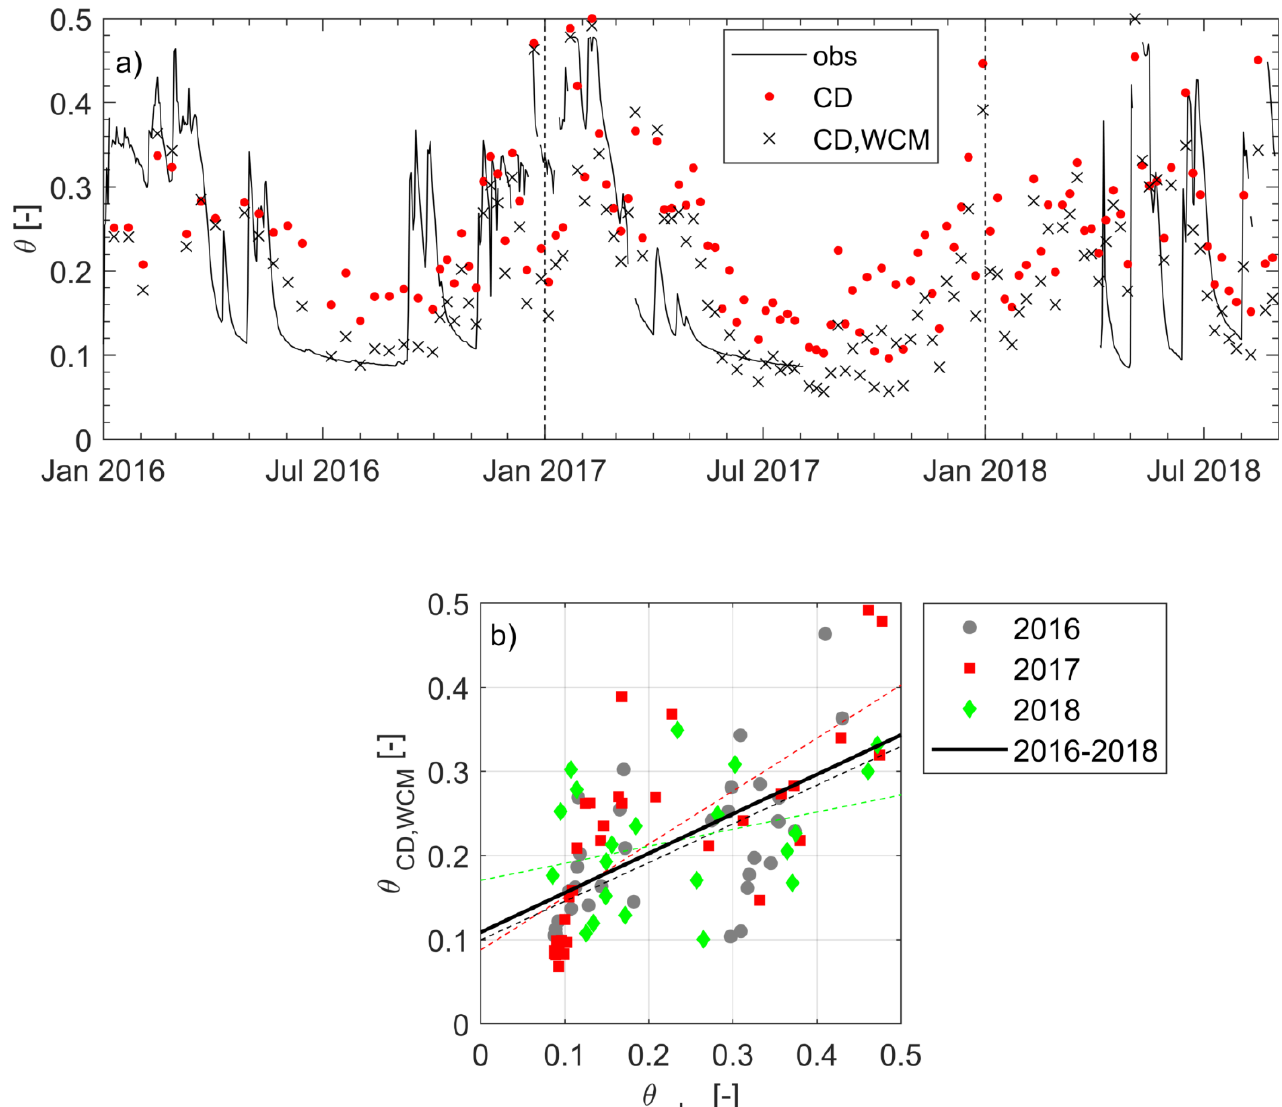
Figure 3. At the grass field: ( a ) soil moisture estimates using the revised change detection method (CD) and the revised change detection method after the WCM vegetation effect removal (CD,WCM), compared with the soil moisture observed in the field (obs); ( b ) soil moisture using the CD,WCM method ( θ CD,WCM ) versus soil moisture observed in the field ( θ obs ) (dotted lines are the linear regressions, with equations θ CD,WCM = 0.5 θ obs + 0.1, R 2 = 0.69 p < 0.01 in 2016; θ CD,WCM = 1.42 θ obs − 0.005; R 2 = 0.74, p < 0.01 in 2017; θ CD,WCM = 0.2 θ obs + 0.17, R 2 = 0.31, p > 0.1 in 2018; the solid line is the linear regression for the whole 2016–2018 period, with equation θ CD,WCM = 0.2 θ obs + 0.41, R 2 = 0.12, p <